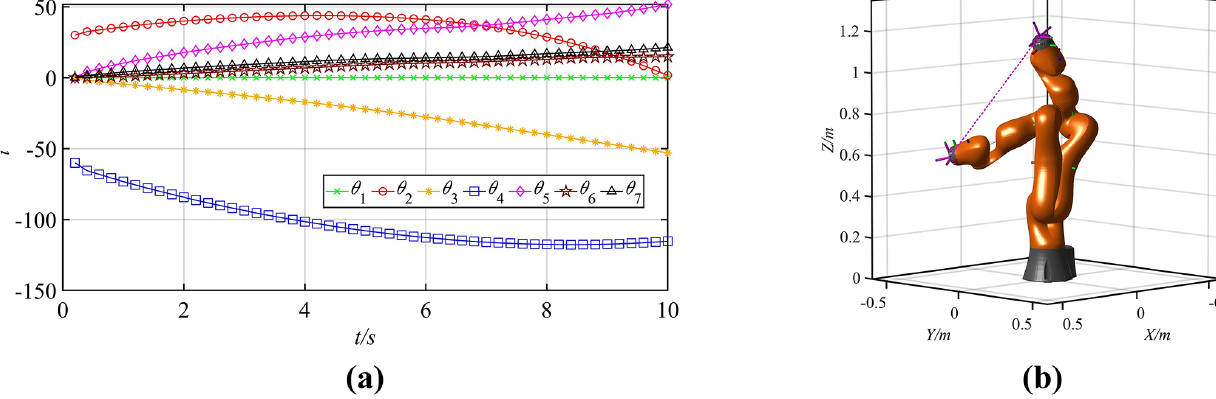
Figure 17. Motion curves of the joints and the manipulator ( k 1 = 0, k 2 = k 3 = k 4 = k 5 = k 6 = k 7 = 1 . 0). (a) Joint motion curves. (b) Tra- jectory of the